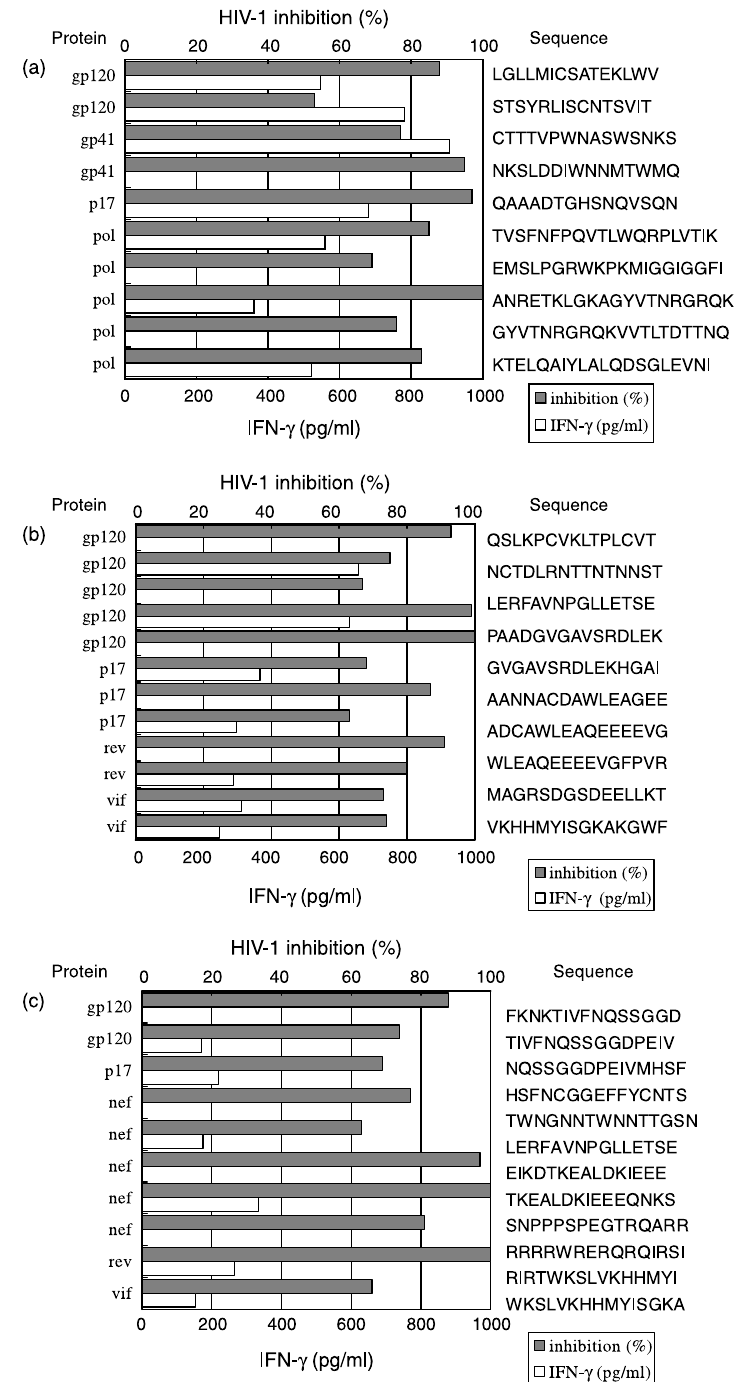
Figure 2. Recognition of various HIV-1 peptides by HIV-1-immune human CD4 þ T cells from three different donors generated in the HIV- DC-immune hu-PBL-SCID mice. HIV-DC immune CD4 þ T cells (2 £ 10 5 cells) were stimulated with various peptides at a concentration of 10 m g/ml in the presence of 2 £ 10 4 APC in a volume of 200 m l in individual wells of a 96-well plate. After 2 days, the culture supernatants were harvested and their activity of R5 HIV-1 inhibition and the levels of human IFN- g were determined as described in the materials and methods. Percent inhibition of HIV-1 production was calculated using values obtained from HIV-1 infected PBMC that were pre-treated with the medium alone. Representative data from three independent experiments for donor 1 (a), donor 2 (b), and donor 3 (c) were